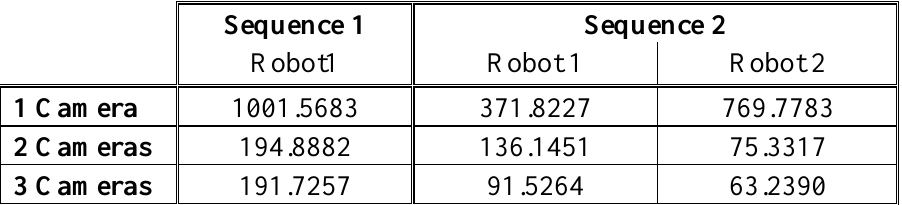
Table 2. Average value of the value of the positioning error (mm) obtained using 500 images belonging to each test